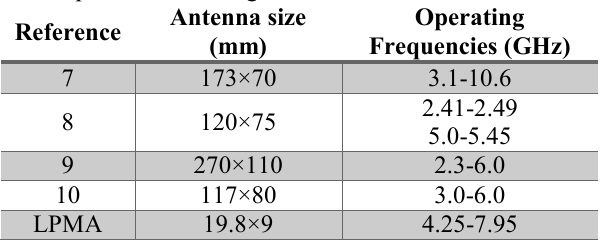
Table 1: Comparison of the LPMA with wideband log periodic printed antennas given in